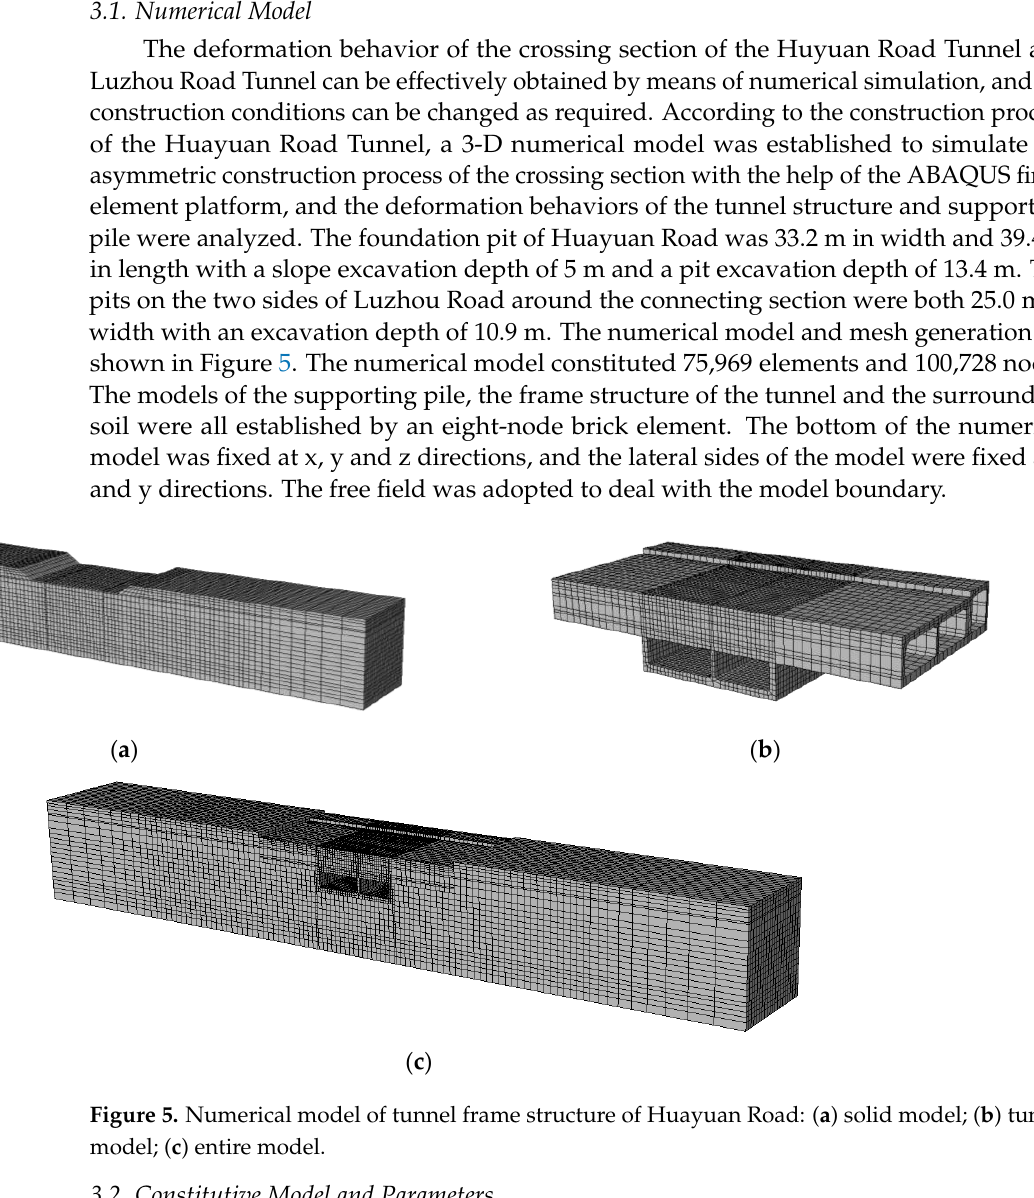
Figure 4. Excavation of foundation pit behind supporting pile.